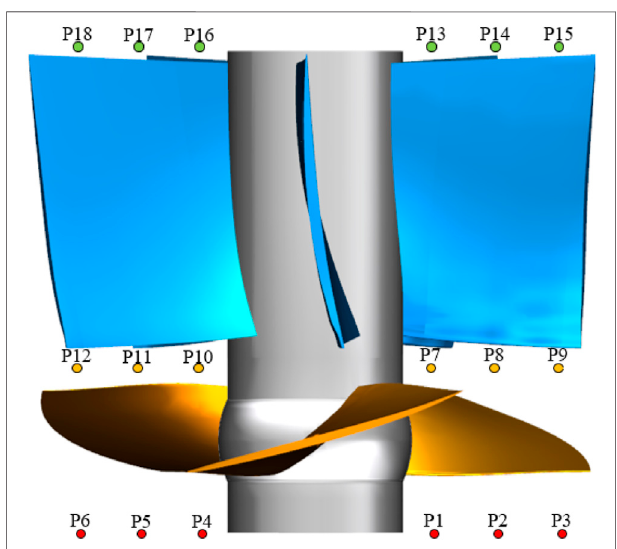
FIGURE 3 | Layout of monitoring